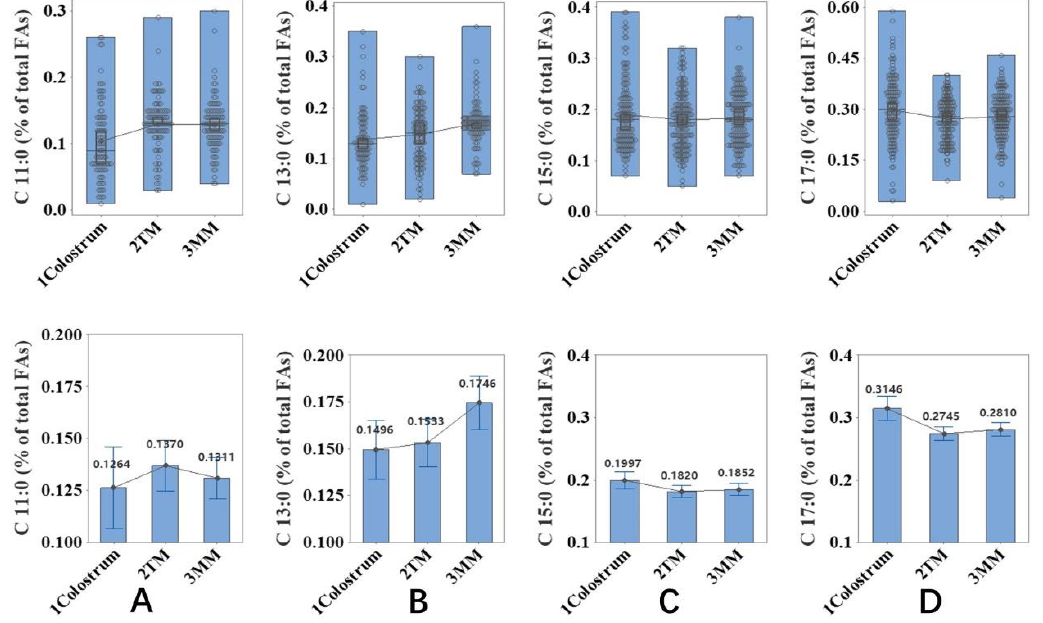
Figure 1. Association between lactation stage and the odd-chain fatty acids (( A ): C11:0, ( B ): C13:0, ( C ): C15:0, ( D ): C17:0) in human milk. Undecylic acid = C11:0; Tridecylic acid = C13:0; Pentadecylic acid = C15:0; Margaric acid = C17:0; TM = Transitional milk; MM = Mature milk.